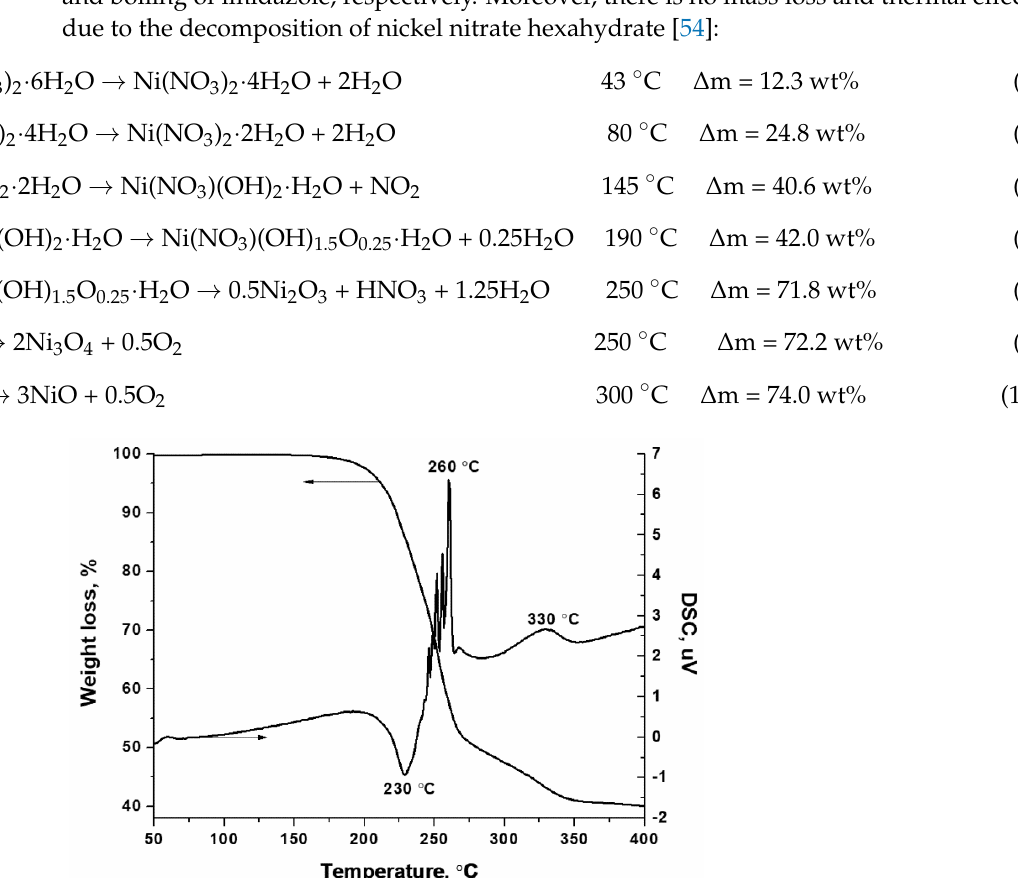
Figure 2. ATR FTIR spectra of the prepared hexakis-(imidazole) nickel (II) nitrate complex and imidazole.